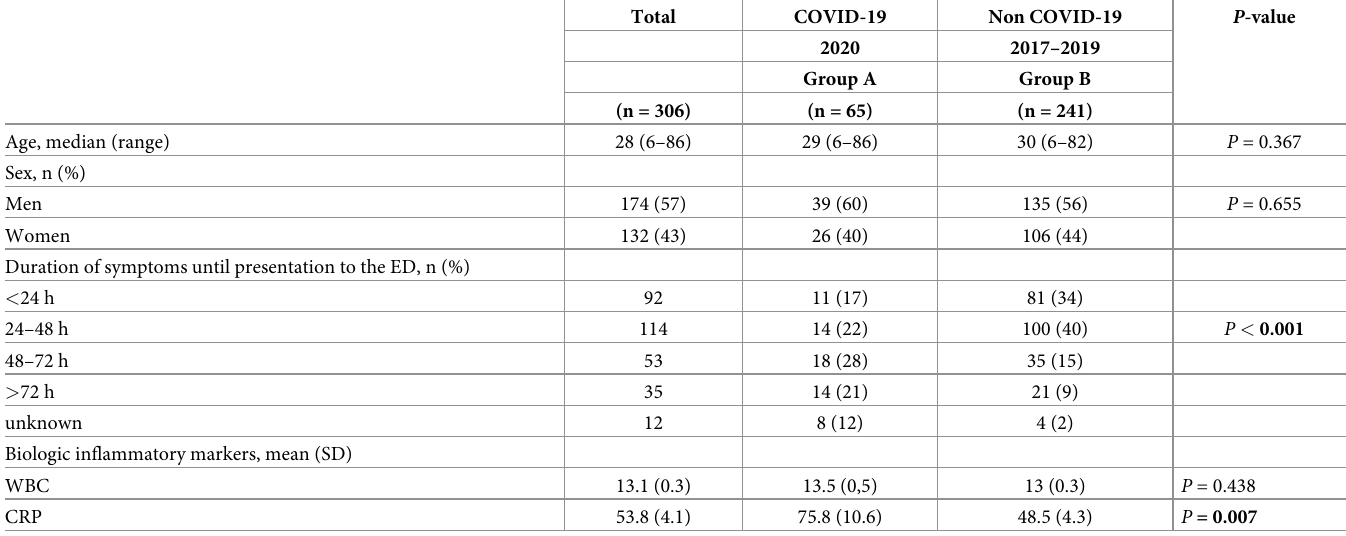
Table 1. Patients’ demographic and preoperative